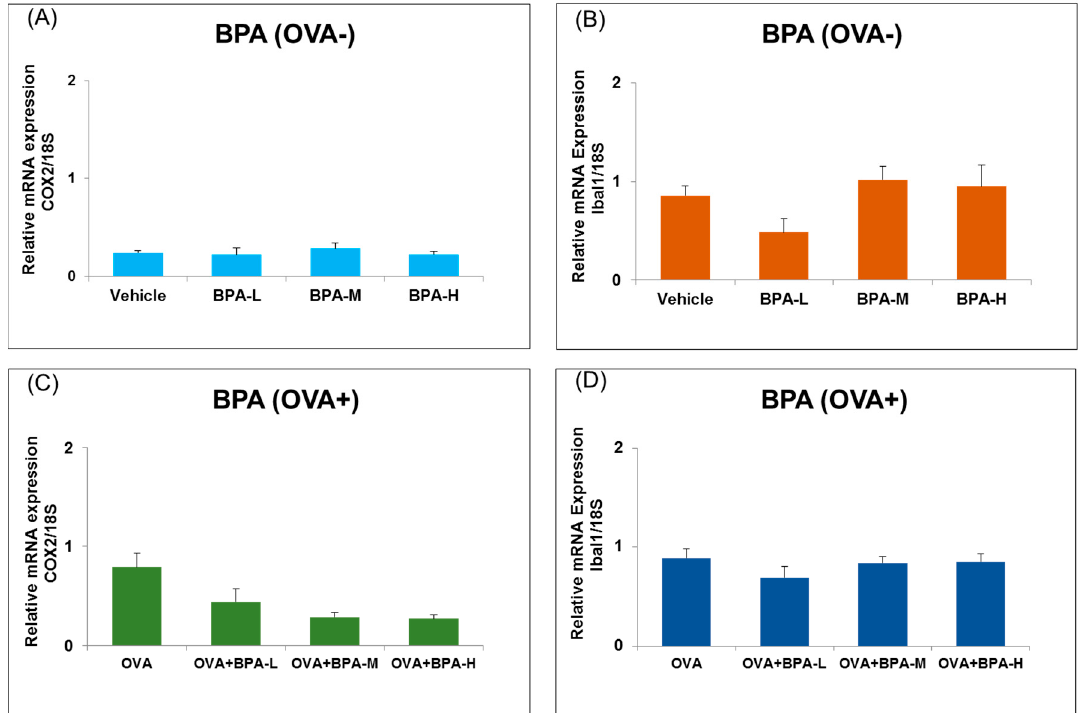
Figure 6. Expression level of inflammatory markers (COX2) and microglia marker (Iba1) in the hypothalamus of male mice exposed to BPA without OVA ( A and B ) and with OVA ( C and D ). Each bar represents the mean + SE ( n = 5~6).